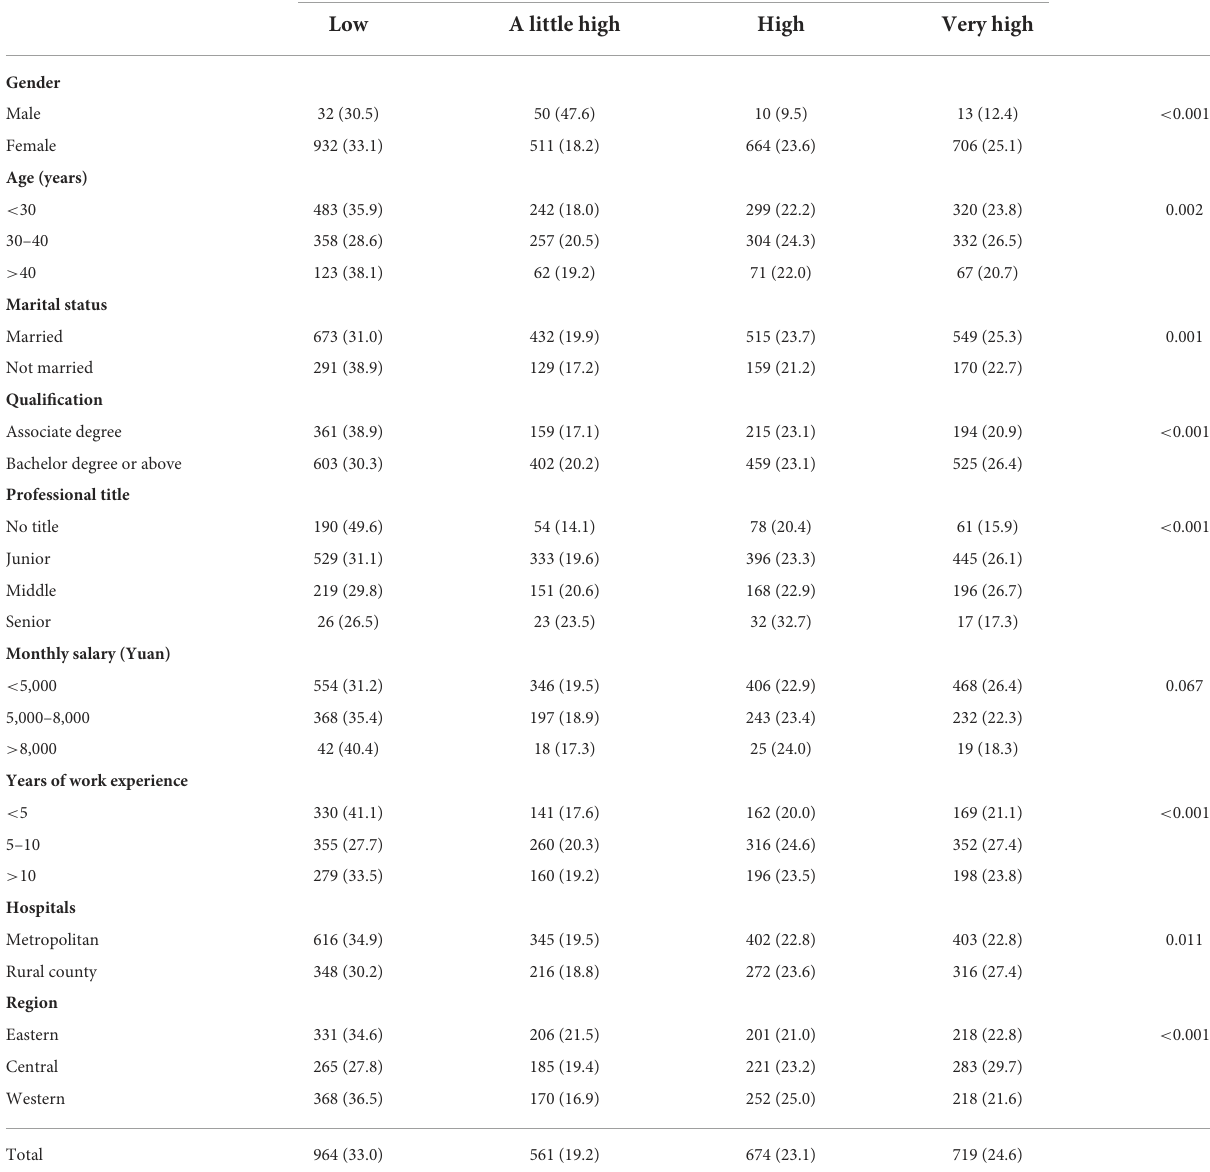
TABLE 4 Sociodemographic characteristics associated with work-related accumulative fatigue ( n = 2,918).